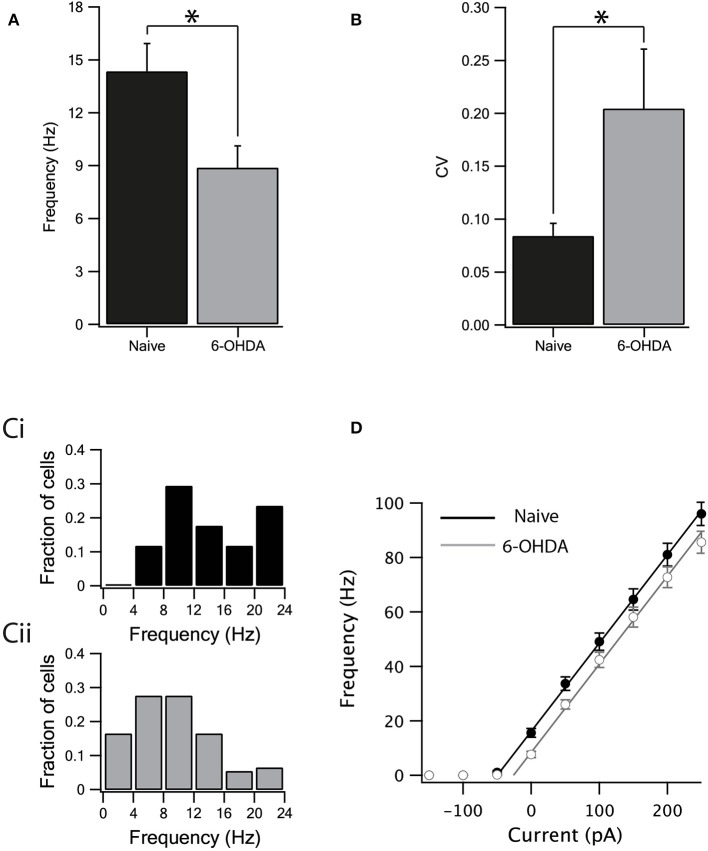
Dopamine depletion decreased the intrinsic excitability of GABA neurons. (A) The spontaneous activity of neurons from naïve rats was higher than the activity of neurons from dopamine depleted rats. (B) The spontaneous activity of neurons from naïve rats was more regular than the activity of neurons from dopamine depleted rats. (C) Spontaneous firing rate distribution recorded from naïve (Ci) and parkinsonian rats (Cii). (D) Firing frequency as a function of current injection. Straight lines are linear curve fits to the rise phase of the curves. Values are expressed as the mean ± SEM. *p < 0.05, Mann–Whitney U-test.